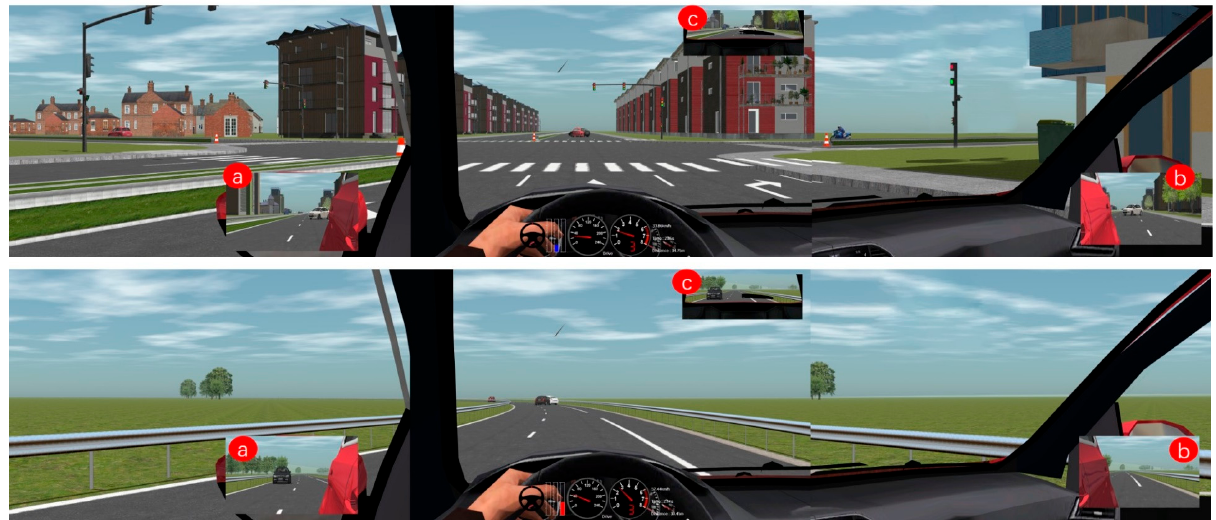
Figure 3. Intersection scenario ( Above ); curve scenario ( Below ); left rearview mirror ( a ); right rear- view mirror ( b ); central rearview mirror ( c ). mirror ( b ); central rearview mirror ( c